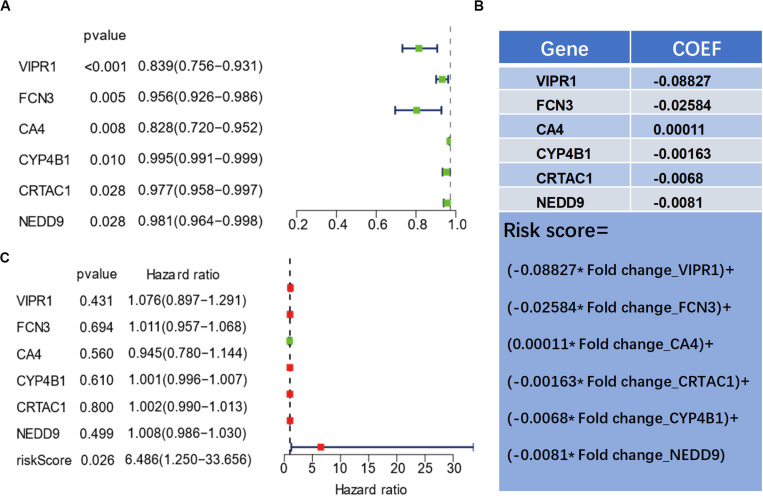
Univariate and multivariate prognostic analyses of genes related to the prognosis of lung adenocarcinoma. (A) Dendrogram of six genes by univariate prognostic analysis. (B) The calculation formula of the comprehensive risk score of the six genes. (C) Results of the risk score by multivariate prognostic analysis.